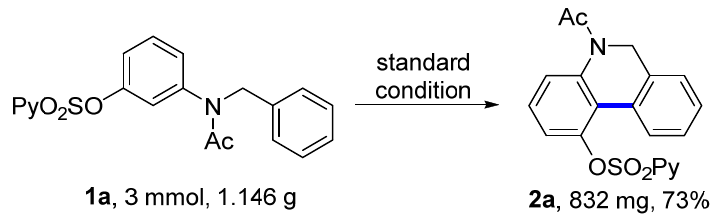
Figure 2. Large-scale experiment. Figure 2 . Large ‐ scale experiment